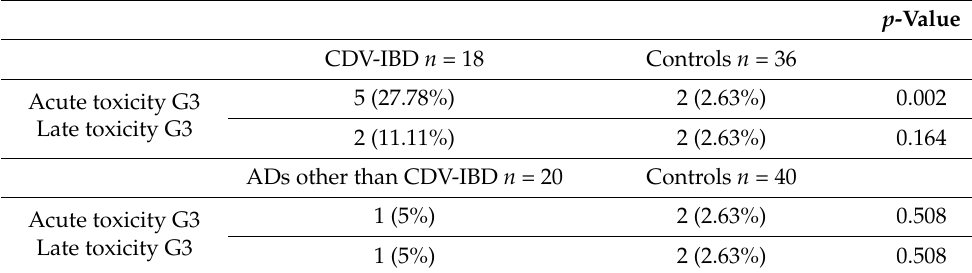
Table 3. High-grade toxicity in CDV-IBD and ADs other than CDV-IBD patients.